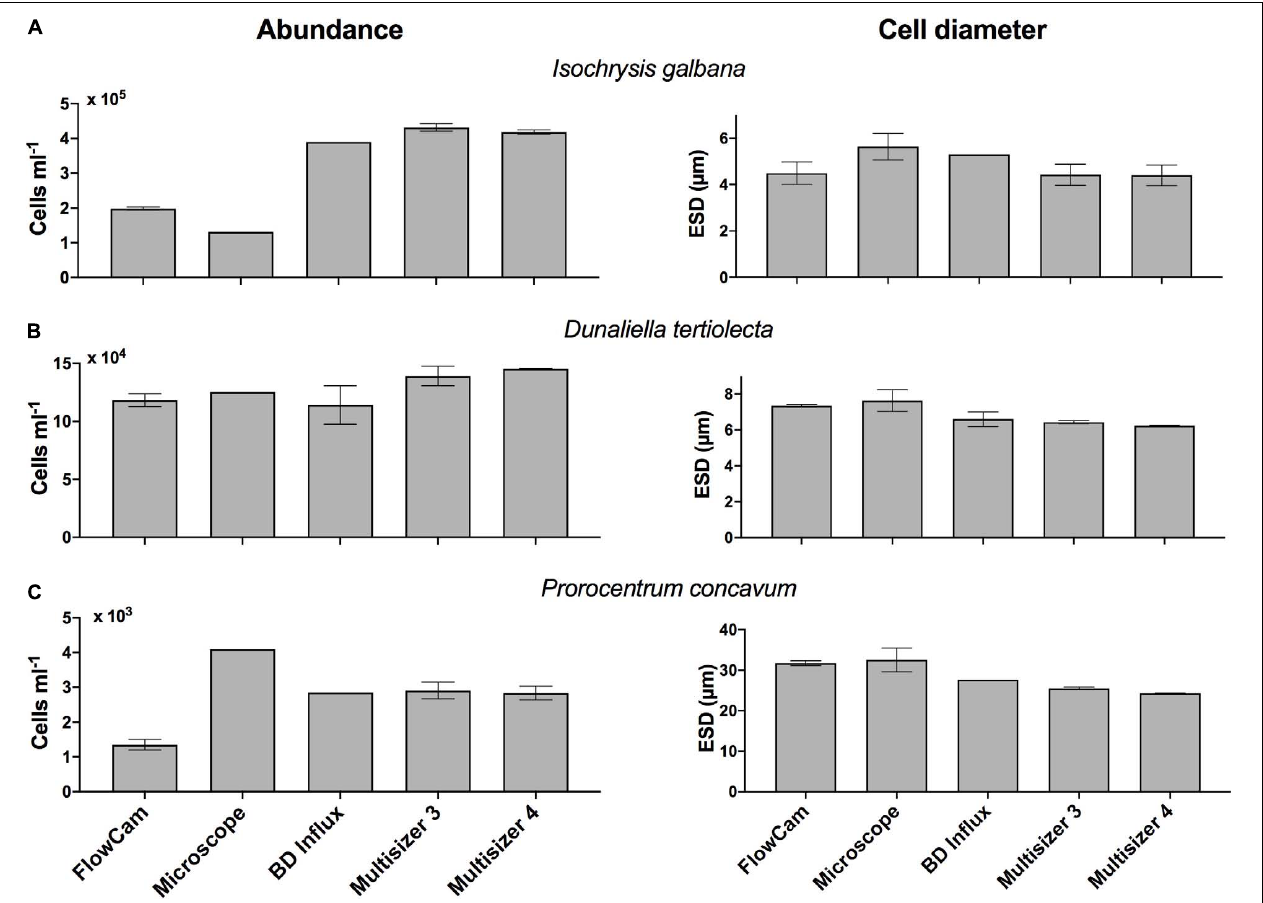
FIGURE 1 | Abundance (cells ml − 1 , left panels) and cell diameter (ESD, right panels) measured with the FlowCam, Micrscocope, BD Influx, Coulter MultiSizer III and IV, for (top row, A ) Isochrysis galbana , (middle row, B ) Dunaliella tertiolecta , and (bottom row, C ) Prorocentrum concavum . Error bars indicate one standard deviation of the